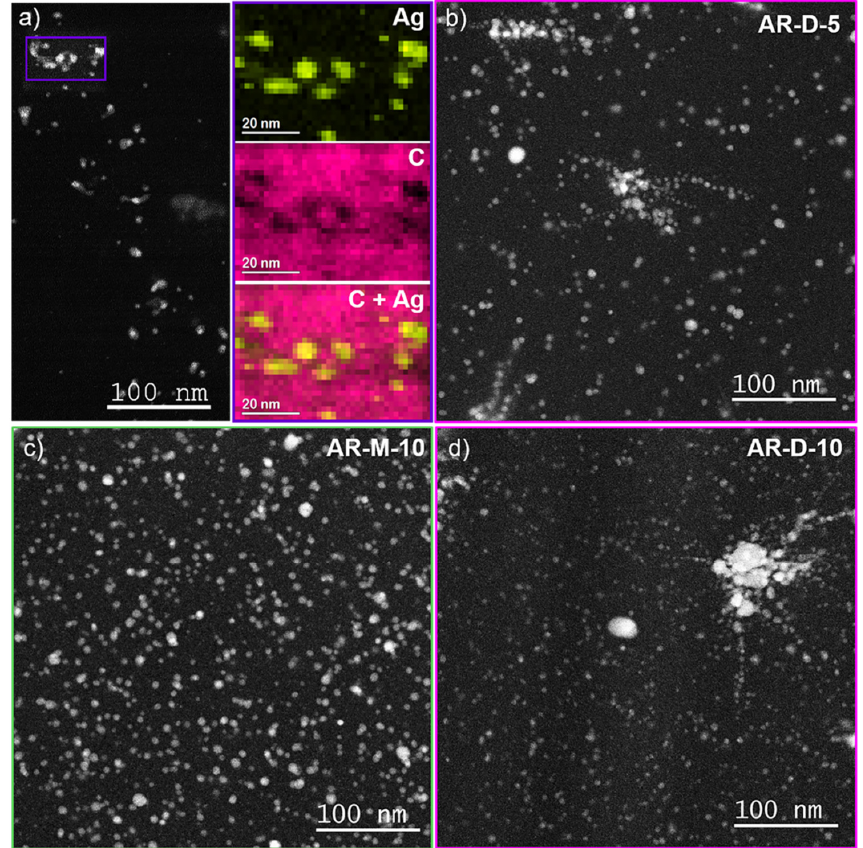
Figure 5. ( a ) HAADF-STEM image of nanocomposite AR-D-5 and EDX map of the squared area showing the Ag signal from the nanoparticles (yellow) and the C signal from the acrylic resin (pink); HAADF-STEM images of 3D printed objects containing acrylic resin, external solvent, and different concentrations of silver precursor: ( b ) AR-D-5; ( c ) AR-M-10, and ( d ) AR-D-10.